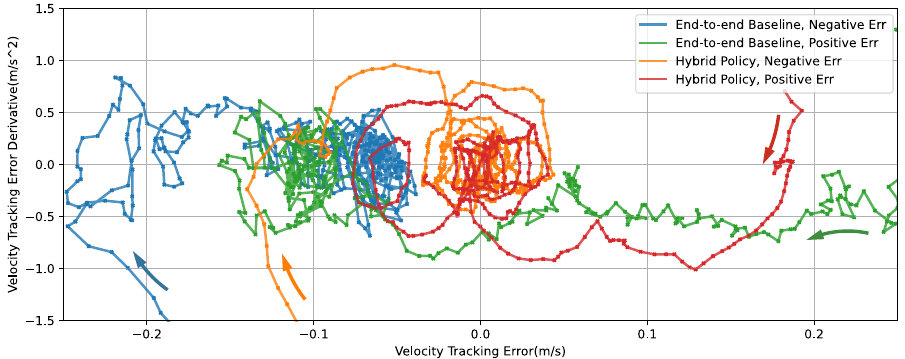
Figure 7. Phase plot of velocity X tracking error. Arrows in different colors indicate the direction of corresponding phase curve. Data obtained from slicing the simulation trajectory in Figure 6.